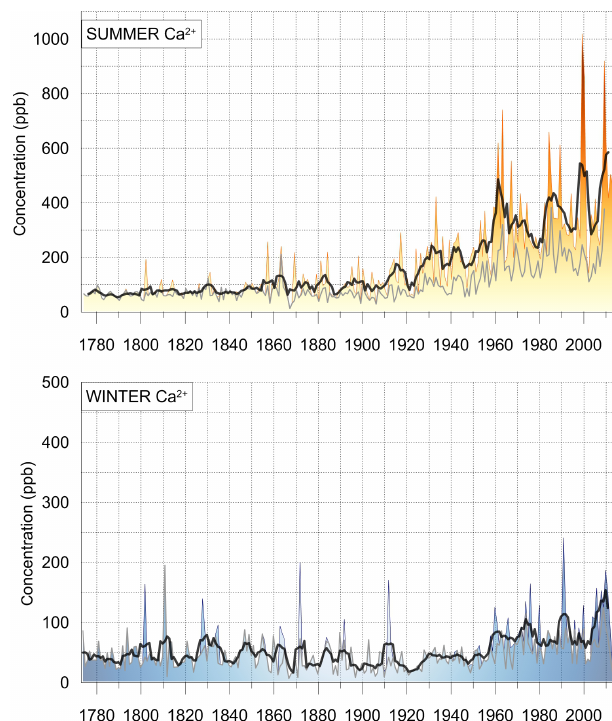
Figure 6. Total and background (grey lines) Ca 2 + concentrations in the Elbrus ice core during summer and winter. The 5-year moving averages are shown as black